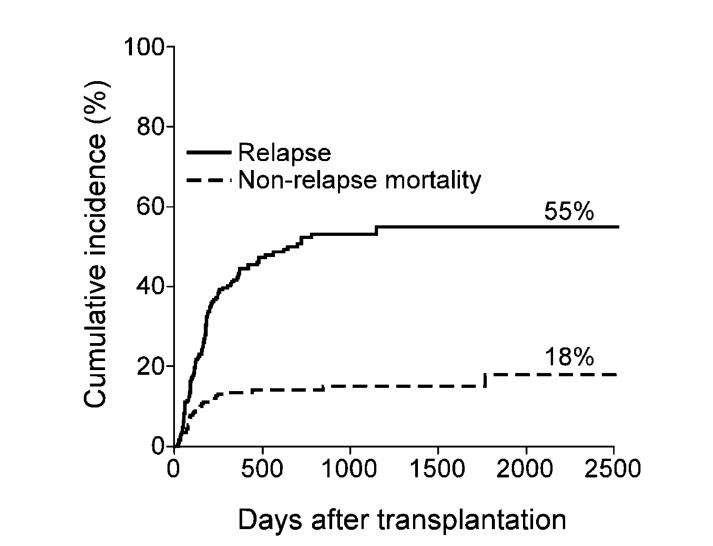
Figure 3. Cumulative incidence of relapse and nonrelapse mortality after nonmyeloabla- tive haploidentical stem cell transplantation with post-transplantation cyclophosphamide.